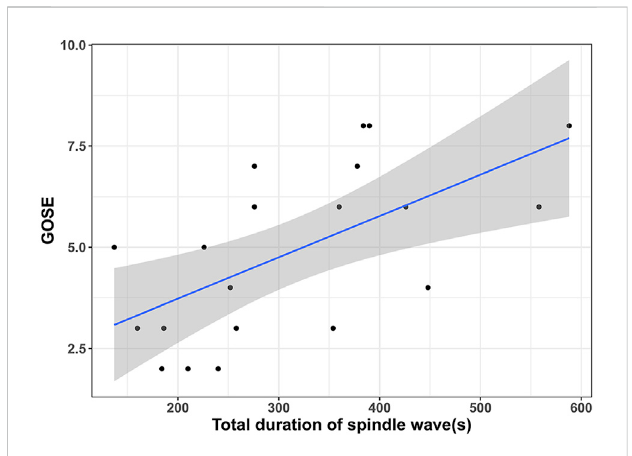
FIGURE 2 | Relationship between the total duration of spindle wave appearanceandtheprognosisofTBIpatientsshowedthatthelongerthe total duration of spindle wave appearance, the higher the patient ’ s Glasgow Outcome Scale-Extended (GOSE) score at 6